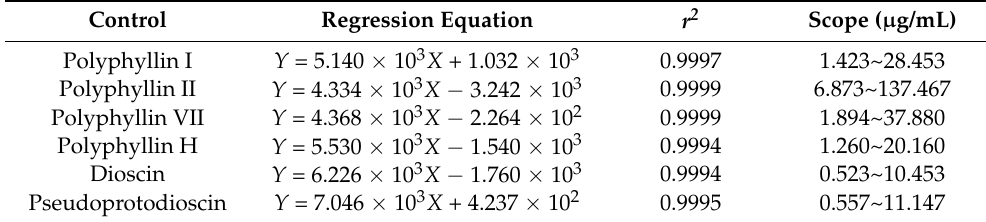
Table 4. Standard regression equation of six steroidal saponins.